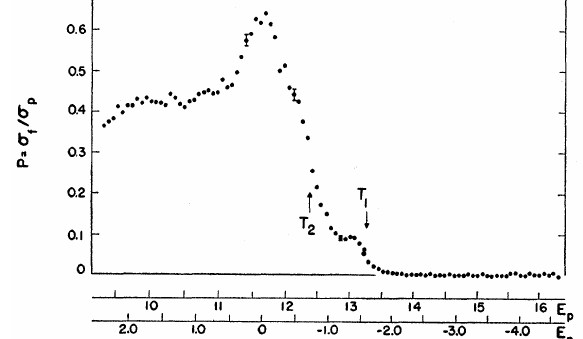
Figure 2. The fission probability measured in 239 Pu(d,pf) reac- tion at E d = 14MeV plotted as a function of the energy, E p , of the outgoing proton taken from Ref. [8]. Note the resonance struc- ture at E p = 13MeV, which corresponds to an excitation energy of 5MeV in the 240 Pu nucleus. Note that negative neutron en- ⇠ ergies (not physical) correspond to excitation energies below the neutron binding energy.